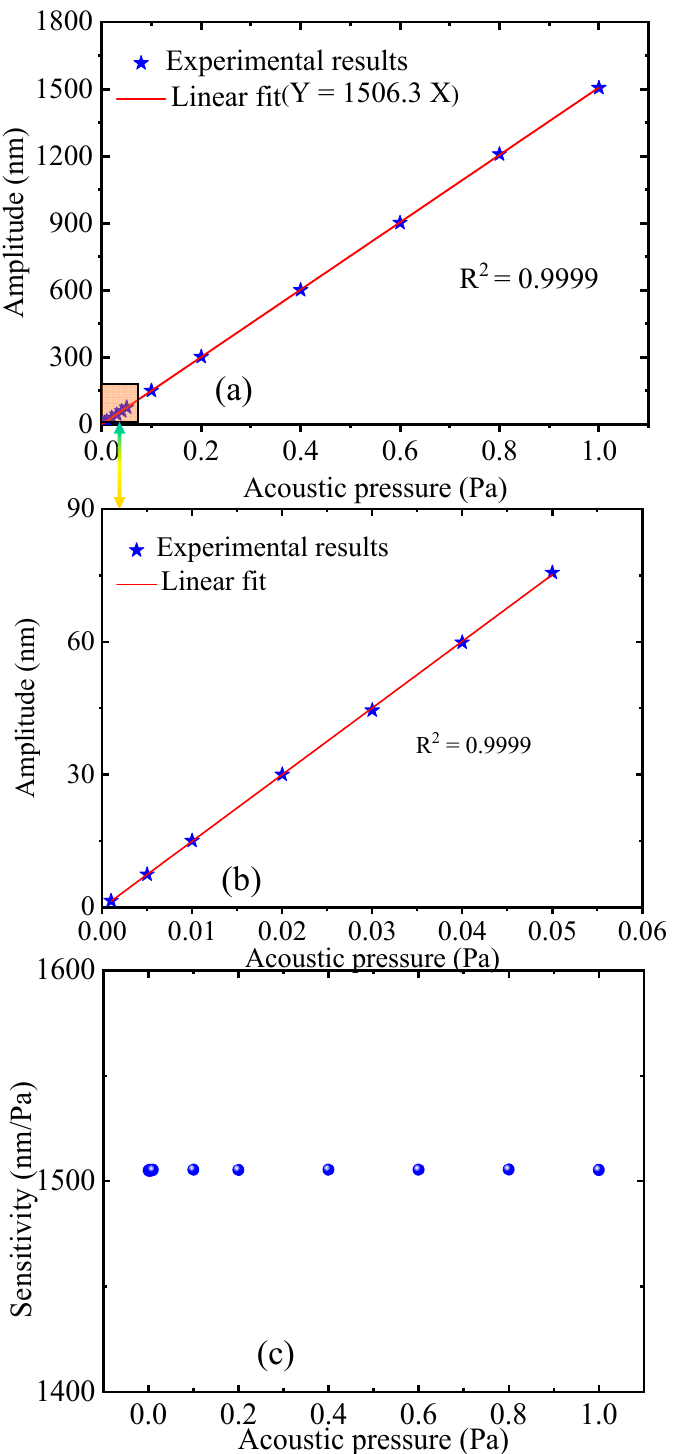
Figure 10. ( a ) The output amplitudes of the designed FOM under different sound pressures; ( b ) the enlarged view of the output amplitude of the designed FOM at 0.001–0.005 Pa; ( c ) the sensitivity at different sound pressures.